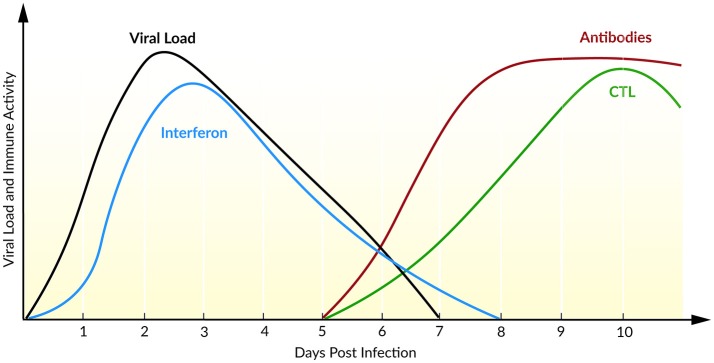
Course of an IAV infection (viral load), the innate immune response (interferon), and the adaptive immune response (antibodies and CTL). Inspired by Beauchemin and Handel (2011) and Wright et al. (2013).